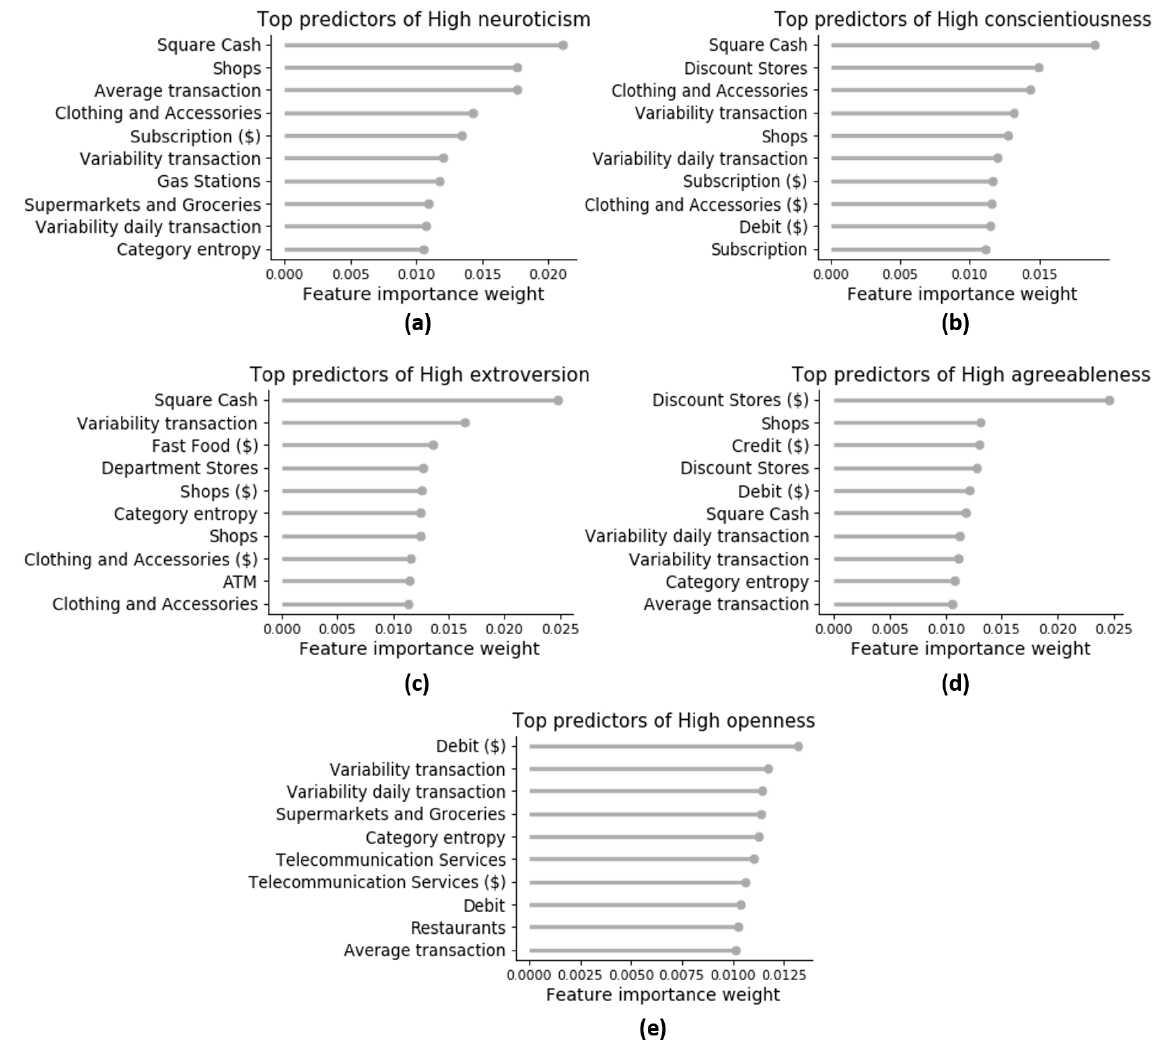
Figure 6. Feature relevance lists that show top features in the model that predicts High levels of ( a ) Neuroticism, ( b ) Consci- entiousness, ( c ) Extraversion, ( d ) Agreeableness, and ( e ) Openness. The importance weights are computed as the average impurity reduction over the trees in the Random